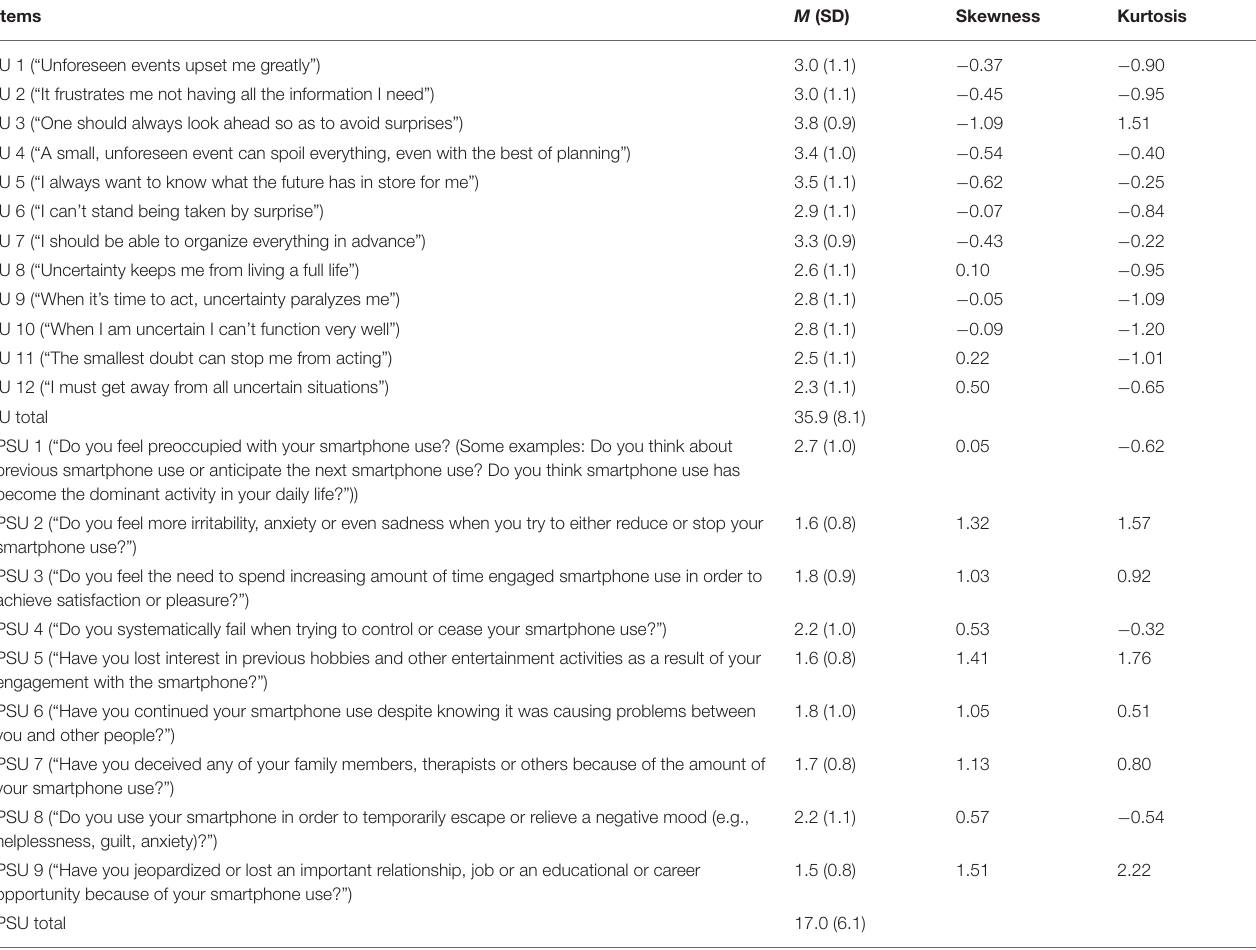
TABLE 1 | Mean, standard deviation (SD), skewness, and kurtosis of each variable selected in the present networks. Items M (SD) Skewness